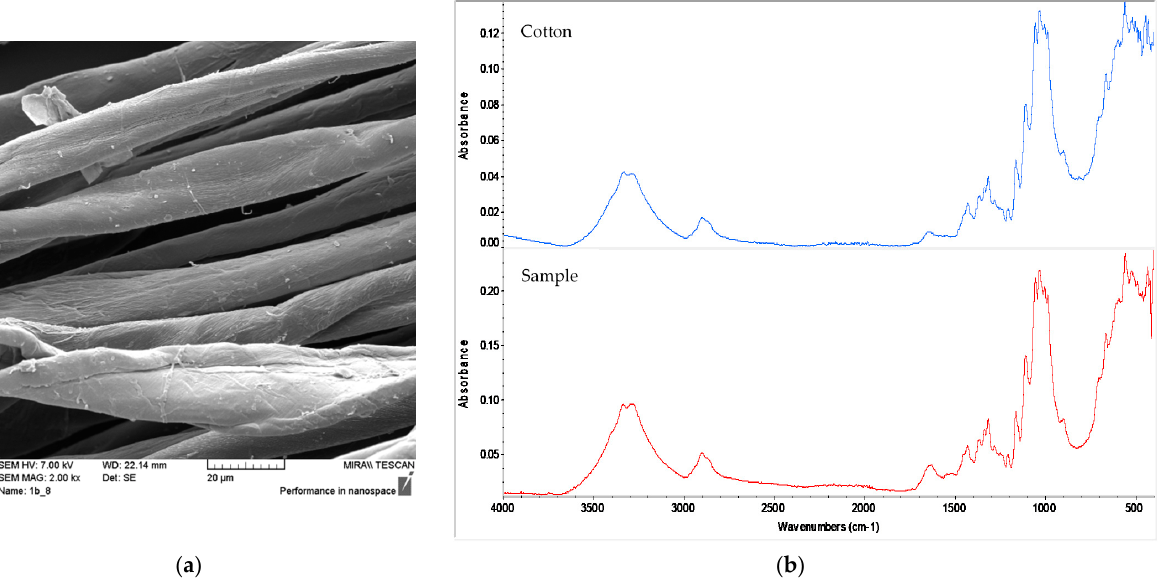
Figure 4. Cotton weft from Fragment 2, sample 8 : ( a ) SEM photograph; ( b ) FTIR-ATR spectra of reference cotton and sample (red).